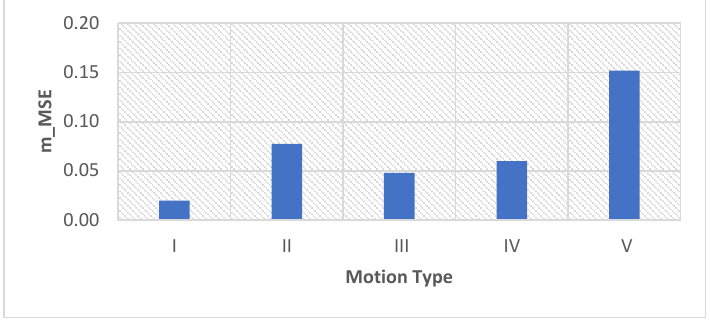
Figure 10. The denoised ECG signal: ( a ) motion type I, ( b ) motion type II, ( c ) motion type III, ( d ) motion type IV, ( e ) motion type V.